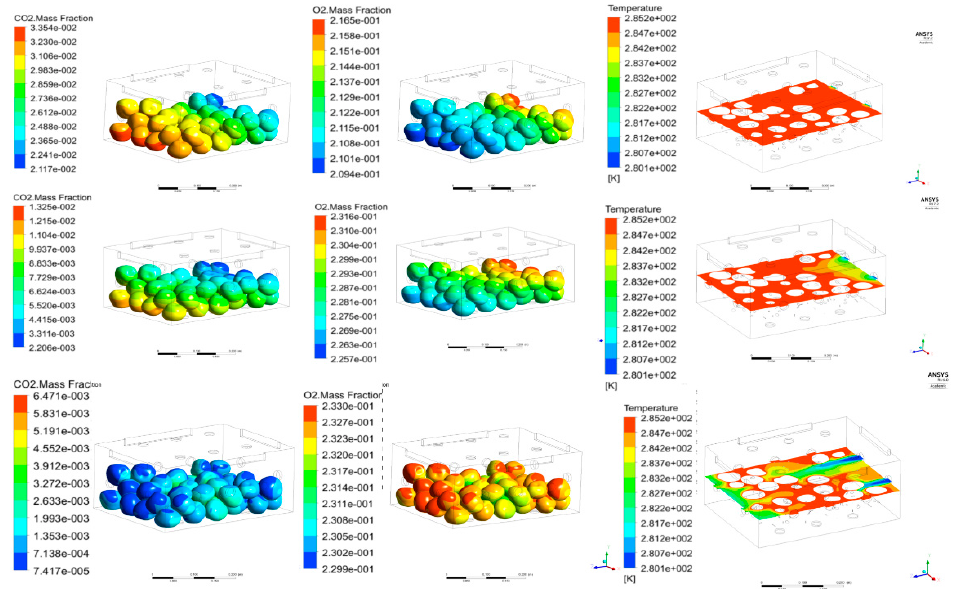
Figure 11. Contours of mass fractions and temperatures for tomatoes after 52 h of simulated storage time. The top row is for Re = 0.1; the middle row for Re = 1; and the bottom row for Re = 50 with flow in the z direction.